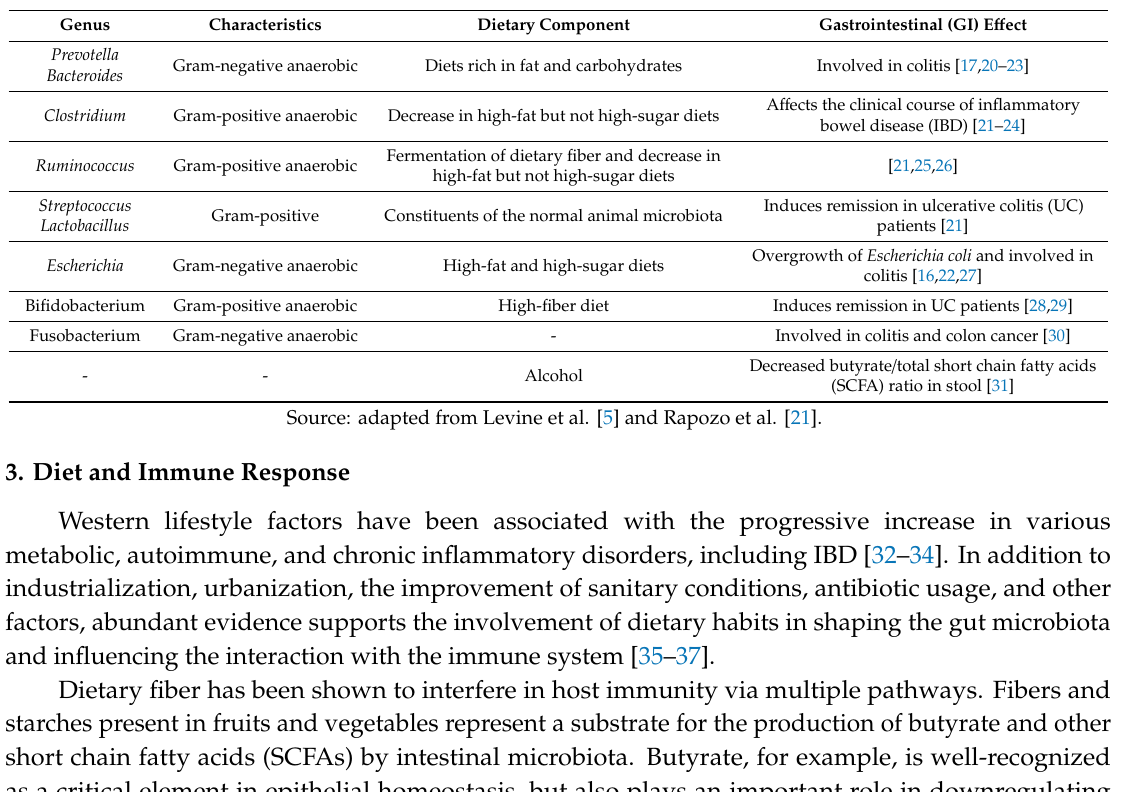
Table 1. Relationship between gut microbiota alterations and dietary